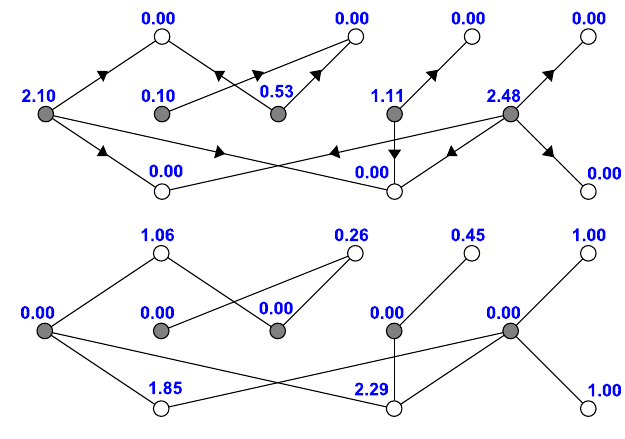
Figure 6: Source and sink parts forming eigenvectors N-eigenvalues 6.14 resp. 0.00